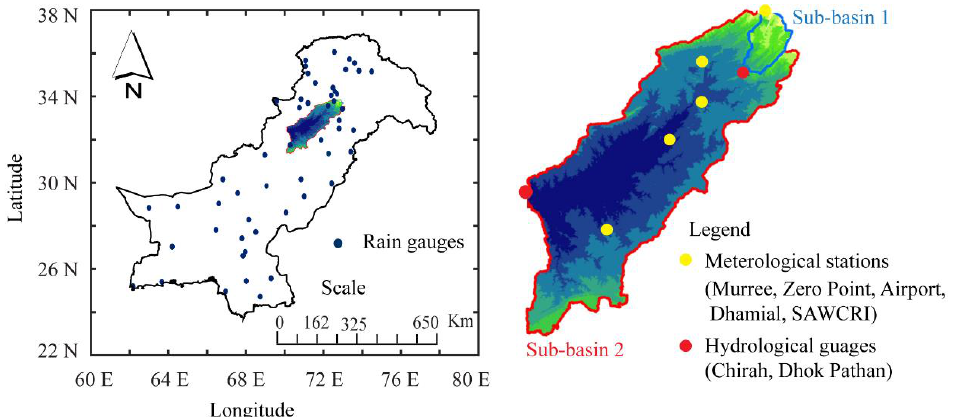
Figure 1. Location map of the study